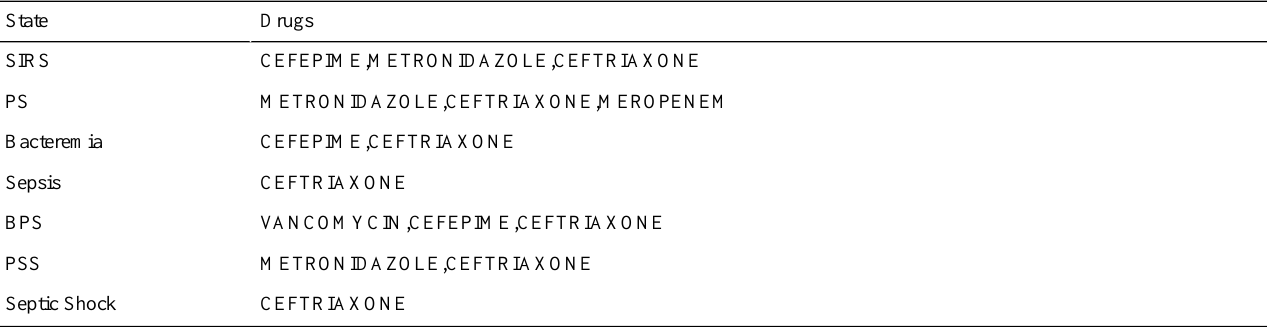
Table 3. Optimal Policy based on from the POMDP CDSS tool. Note that this result assumes that current state is known and given in the state column (Belief/Probability of 1).